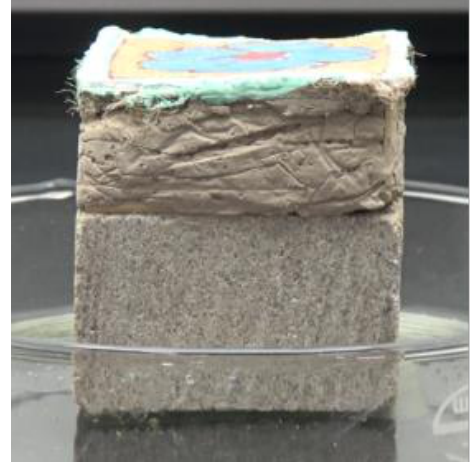
Figure 2. The simulated wall painting sample.